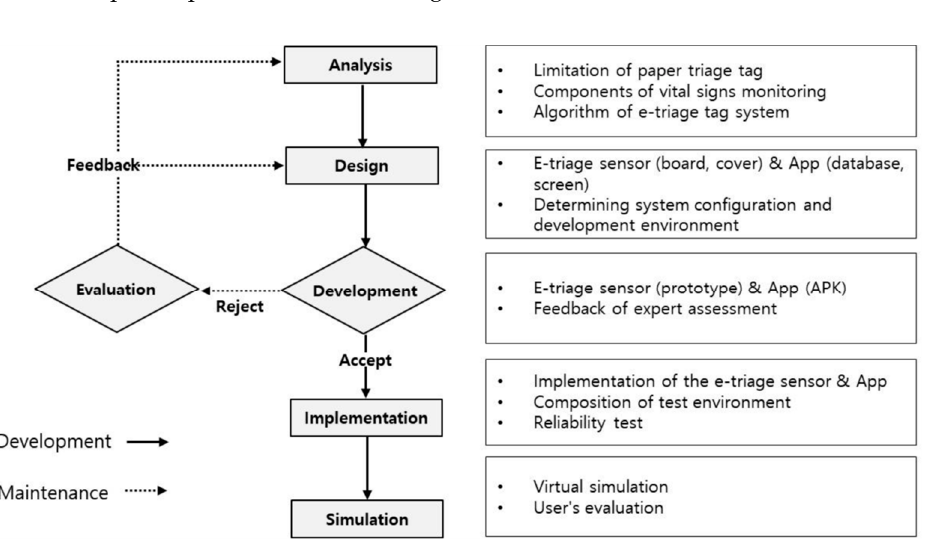
Figure 1. Development Processes of e-triage Tag System.